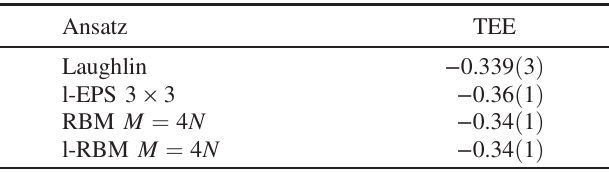
TABLE II. Topological entanglement entropy (TEE) of the analytical Laughlin state and optimized l-EPS, RBM, and l-RBM. Ansatz TEE